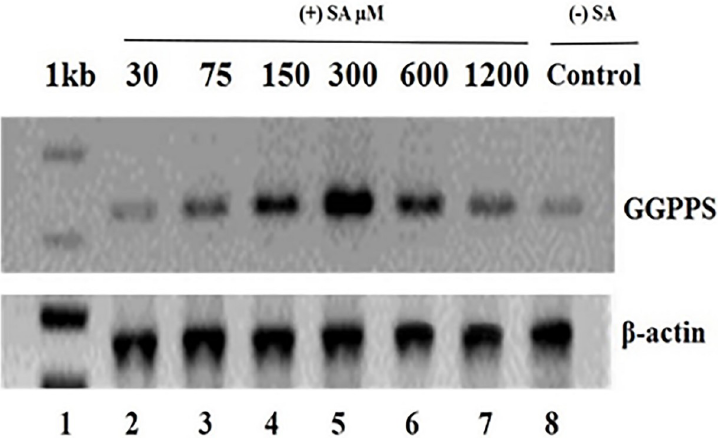
Fig 9. Expression profile of GGPPS after induction by SA. Total RNA was isolated from control and SA treated mycelia of P . microspora (upper panel). Actin gene was used as the control to show the normalization of quantification of RT-PCR reaction (Lower panel). The value of each concentration point is mean ± SD (n = 3). Lane 1: Marker; Lanes 2–7: 30, 75, 150, 300, 600 and 1200 μ M of SA induced protein; Lane 8: control (M1D medium). metabolism (44.1 kDa), nucleic acid metabolism (45.7-kDa protein), protein metabolism and